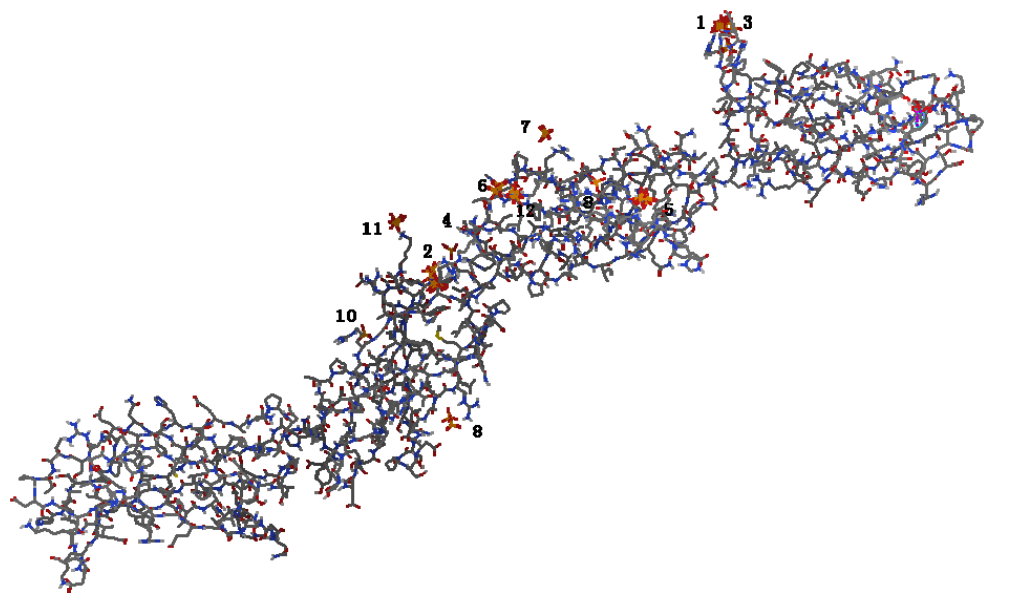
Figure 3. Highest scoring binding sites for top 4 binding clusters between FN (stick) and HAP (ball). The bold sticks show the direct bonding amino